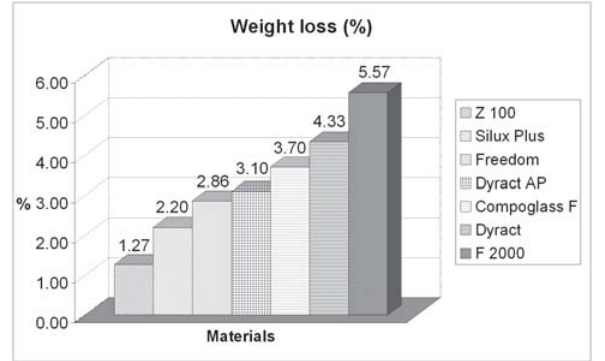
FIGURE 1- Percentage of weight loss of tested materials after simulated toothbrushing abrasion